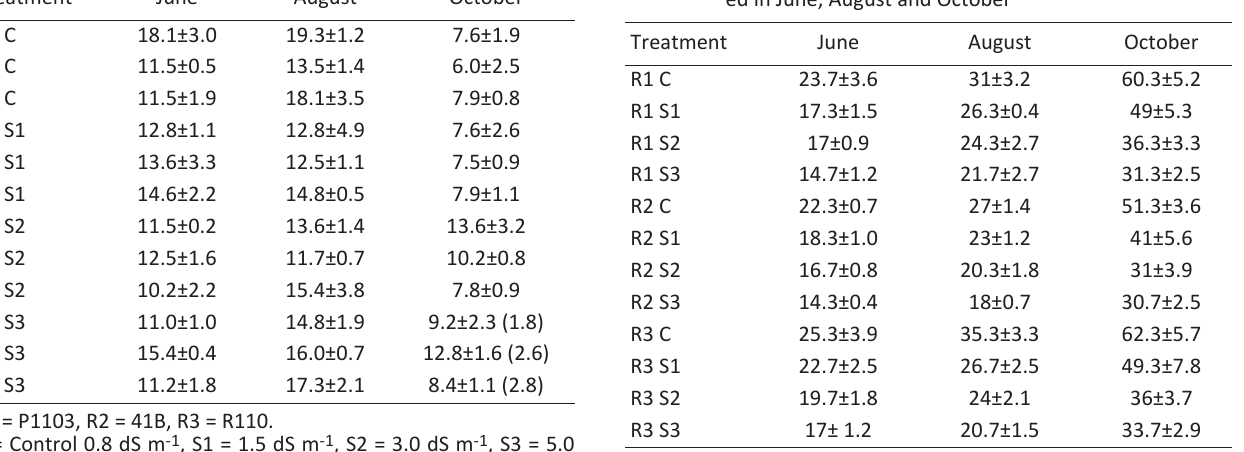
weight) grafted on the three rootstocks measured in April, June and november Treatment